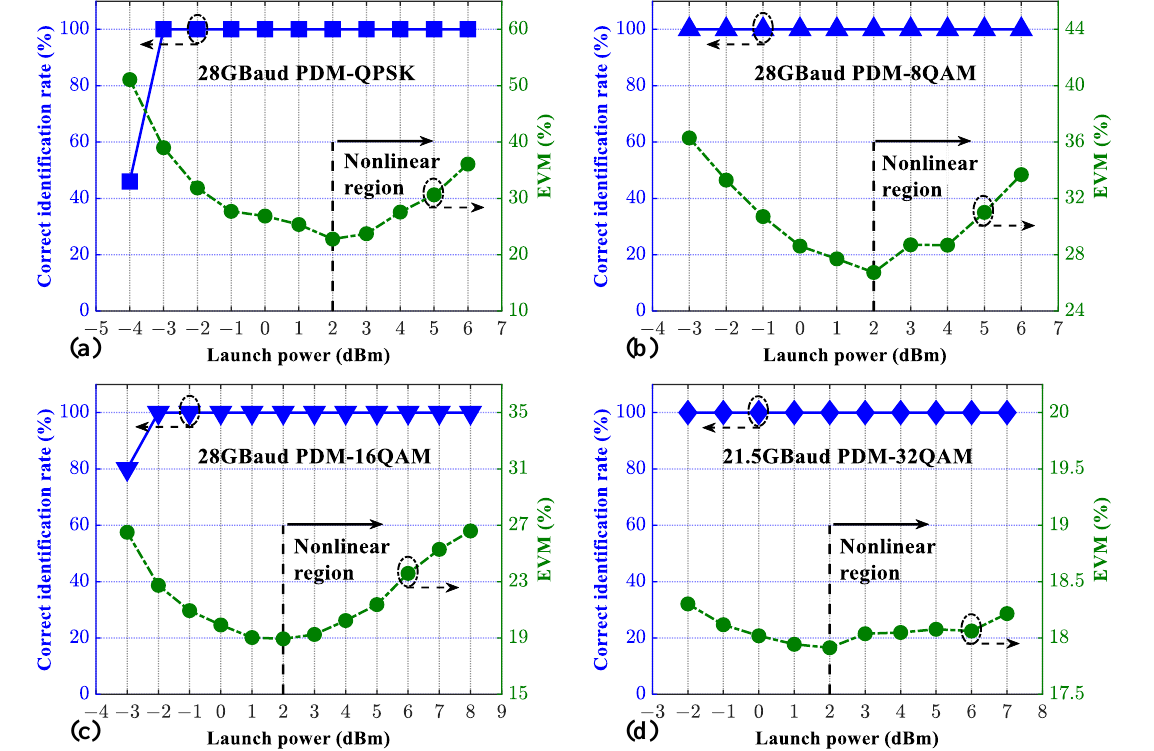
Figure 17. Correct identification rates (blue triangles) of the four modulation formats with different launch powers in long-haul transmission experiments. ( a ) PDM-QPSKsignals over a 2000 km link; ( b ) PDM-8QAM signals over a 2000 km link; ( c ) PDM-16QAM signals over a 1040 km link; ( d ) PDM-32QAM signals over a 400 km link. Green dots indicate the error vector magnitudes (EVM).